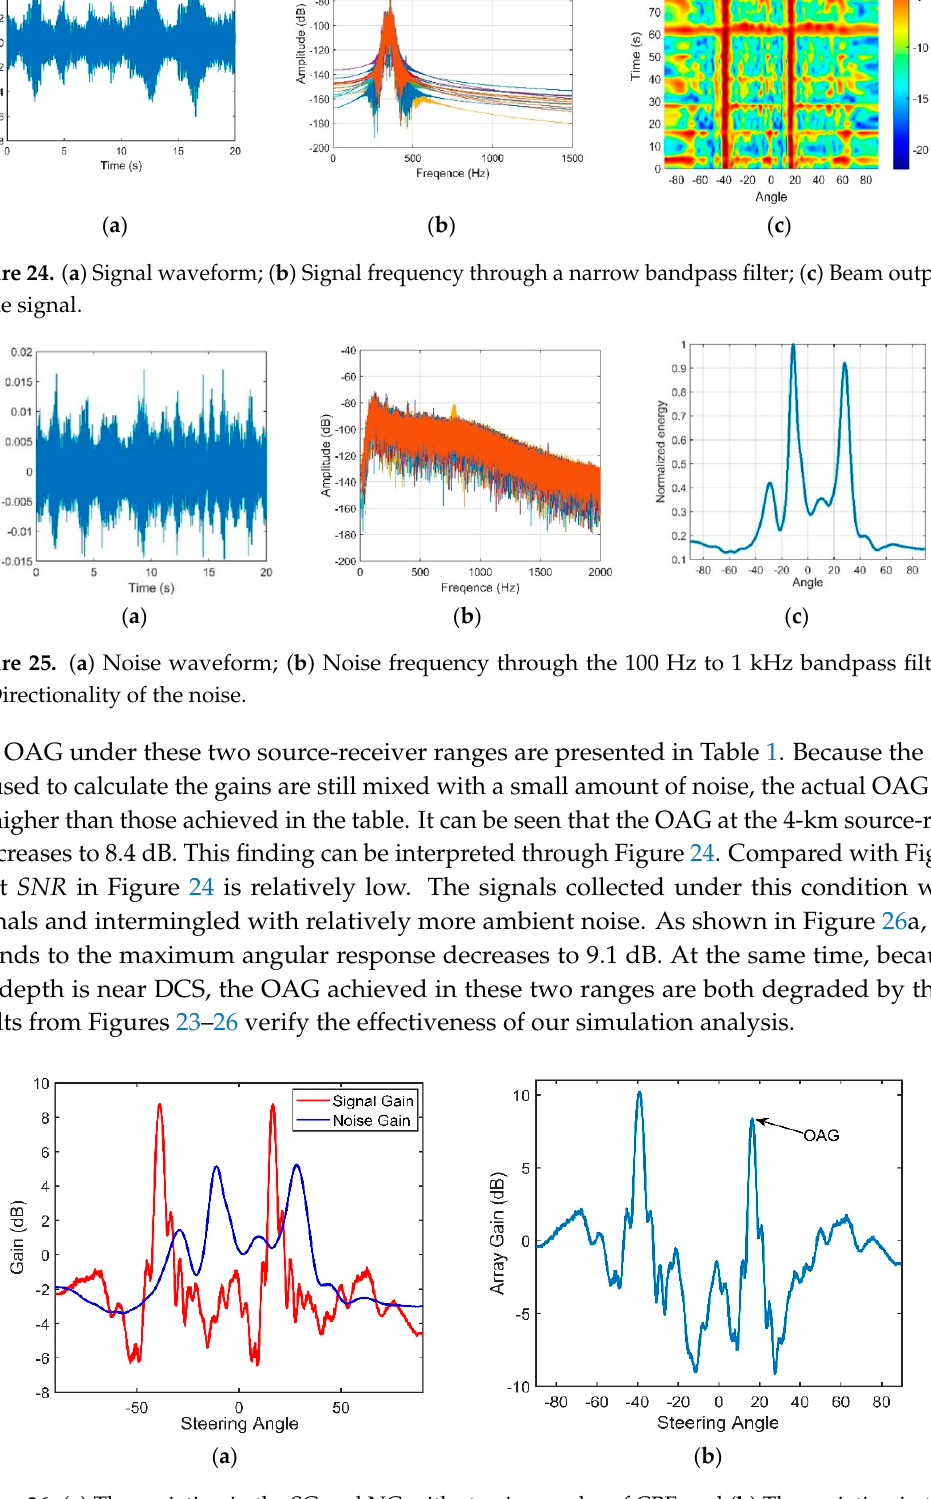
Figure 26. ( a ) The variation in the SG and NG with steering angles of CBF, and ( b ) The variation in the optimal array gain with steering angles of CBF under a 4-km source